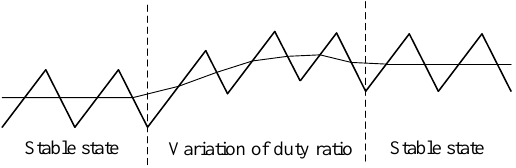
Figure 5. The changing process of phase current in the TIDC.